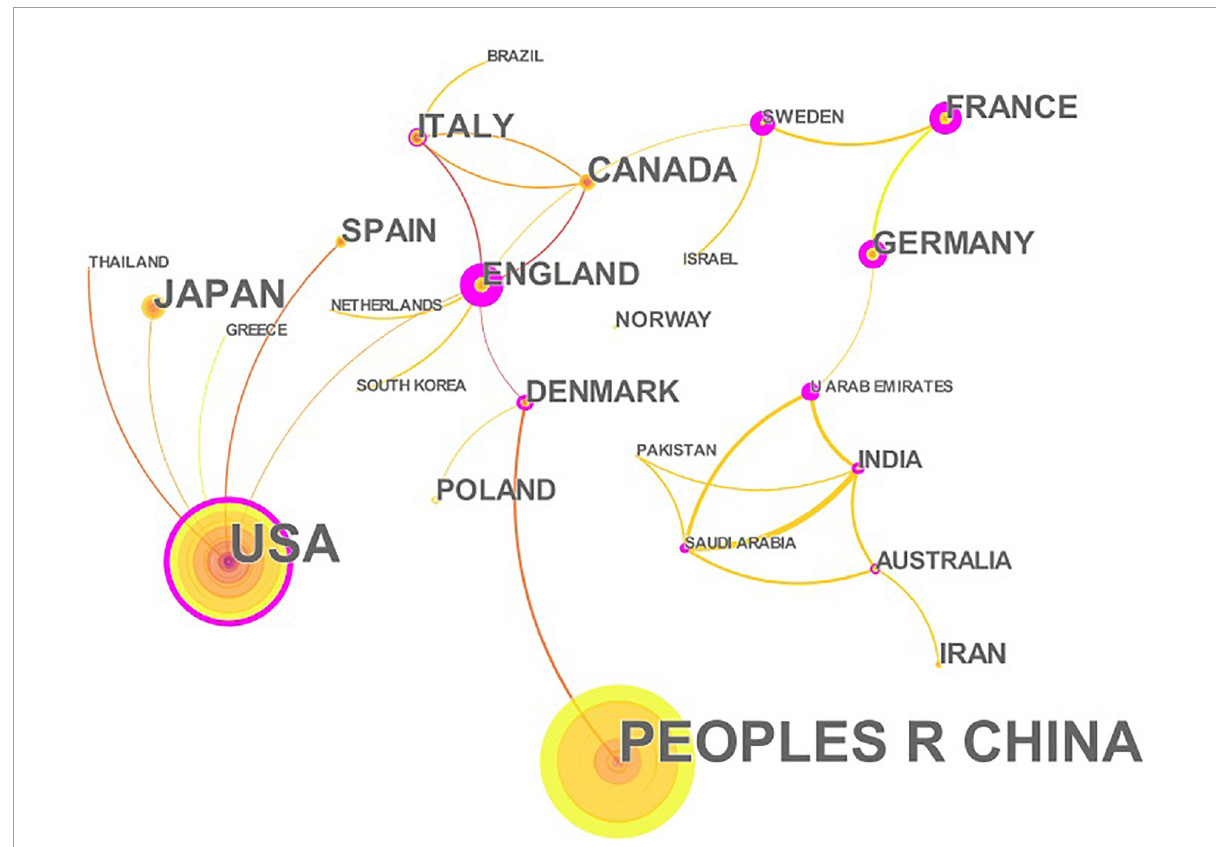
FIGURE4 The network of countries/territories engaged in the research about CHD and gut microbiota. In the networks, the larger the node was, the more contribution the country/territory had made to that field. The nodes with higher centrality ( > 0.1) are highlighted with purple rings. The color of the line represents the time of first co-occurrence. The thicker the line is, the greater the connection strength is (calculation method based on